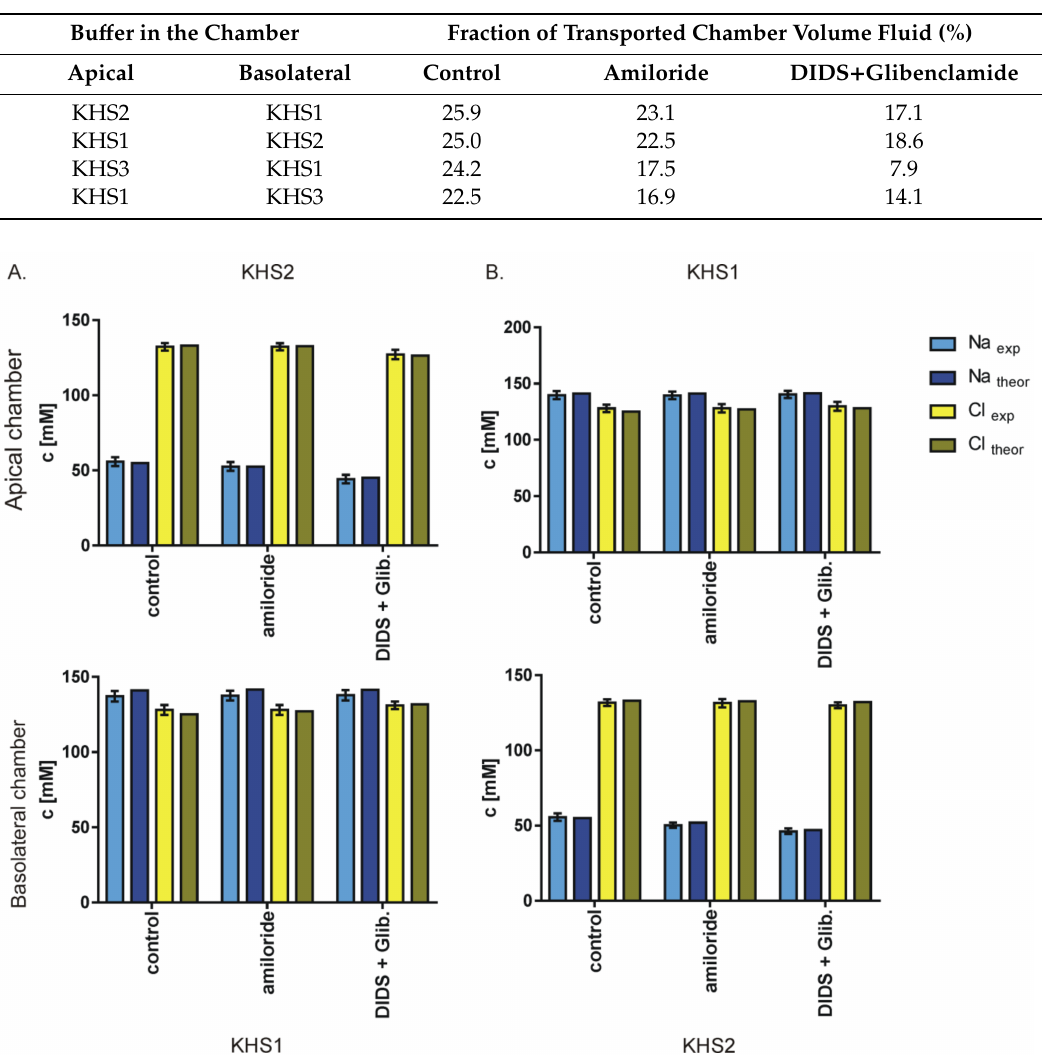
Table 2. Fractions of chamber volume transported in experimental conditions calculated to obtain the best fit between experimental and theoretical predictions.